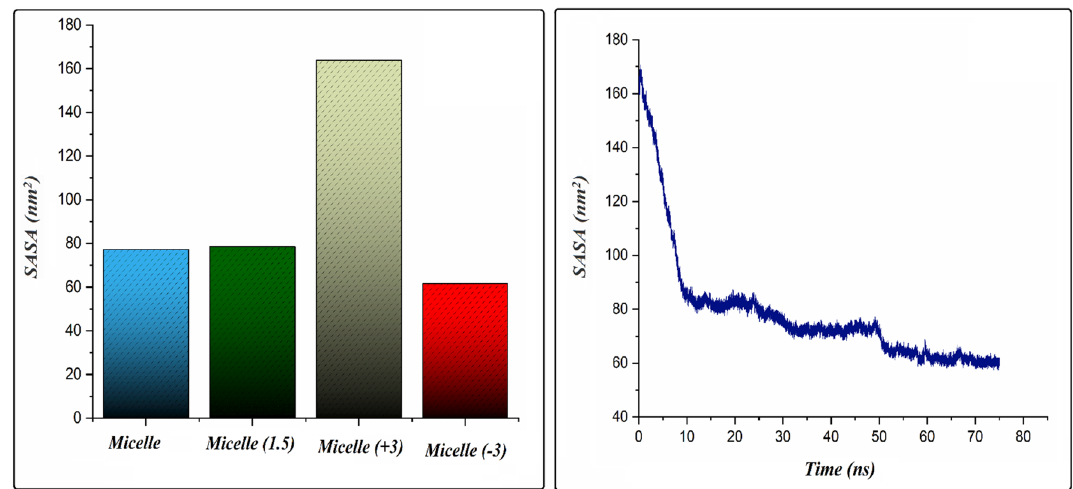
Figure 4. Average value of the solvent accessible surface area (SASA) for PS-β-CD/PE-FE molecules in the investigated systems (left) and the variations of SASA in Micelle system as a function of simulation time